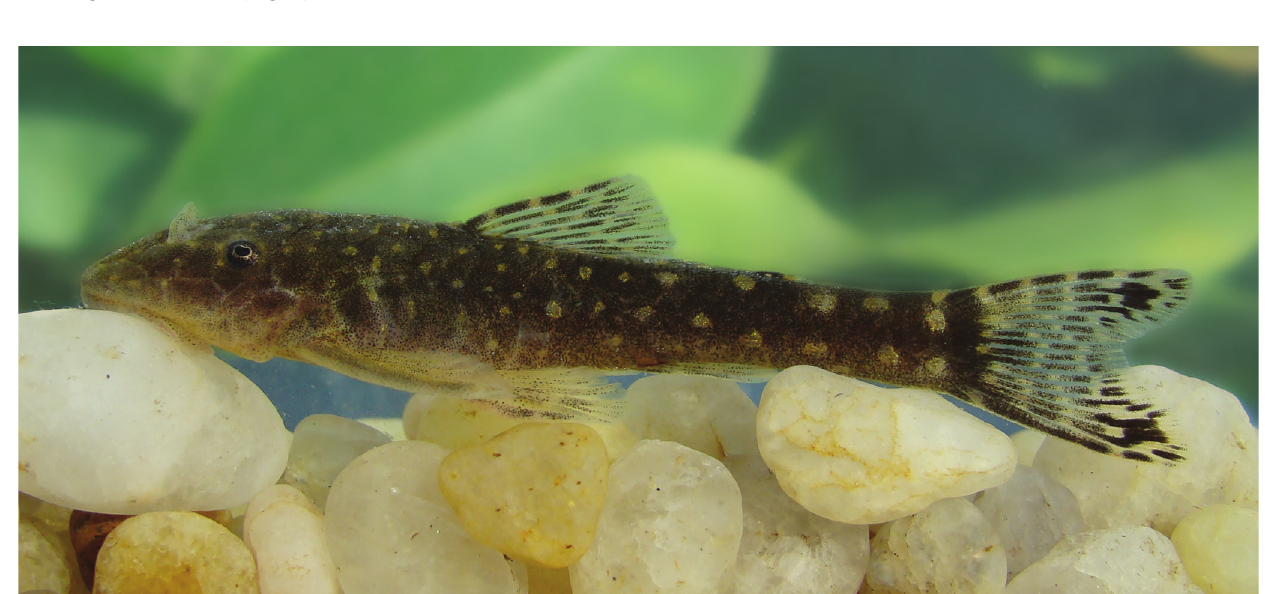
Fig. 4. Parotocinclus spilurus , live (UFRN 1255, 37.2 mm SL) specimen just after collection from rio Salgado (type locality), Icó,